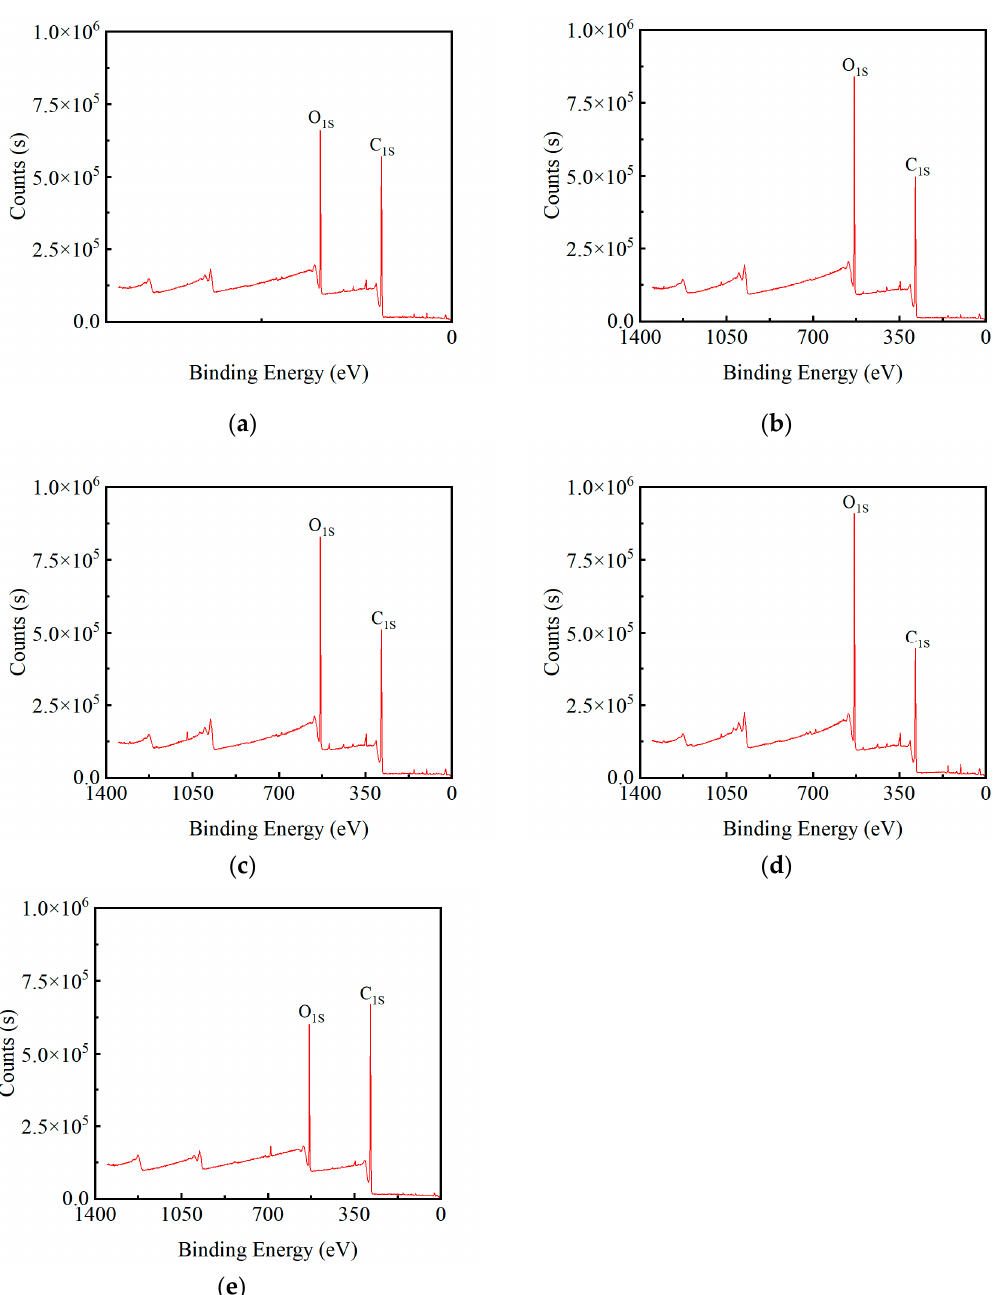
Figure 19. XPS spectra of samples treated with a different number of flame treatments: ( a ) no flame treatment; ( b ) one flame treatment; ( c ) three flame treatments; ( d ) five flame treatments; ( e ) seven flame treatments.